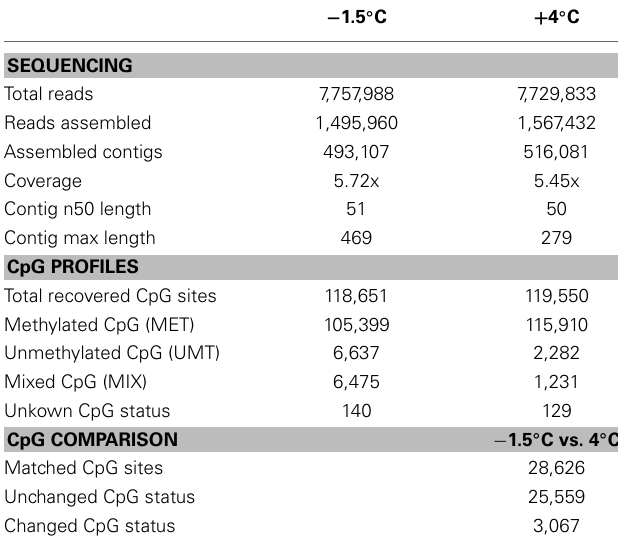
Table 1 | Sequence and assembly